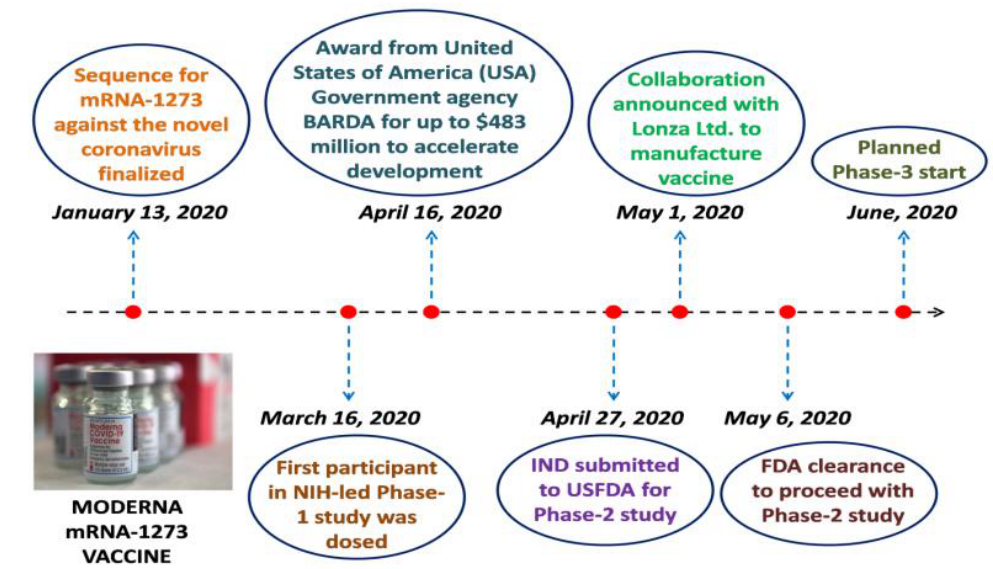
Figure 2. The developmental progress of the Moderna mRNA-1273 Figure 2 The developmental progress of the Moderna mRNA-1273 vaccine.